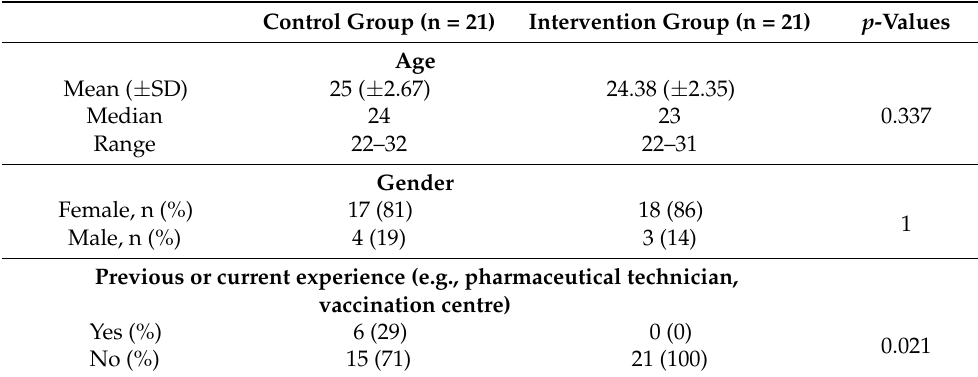
Table 1. Participant